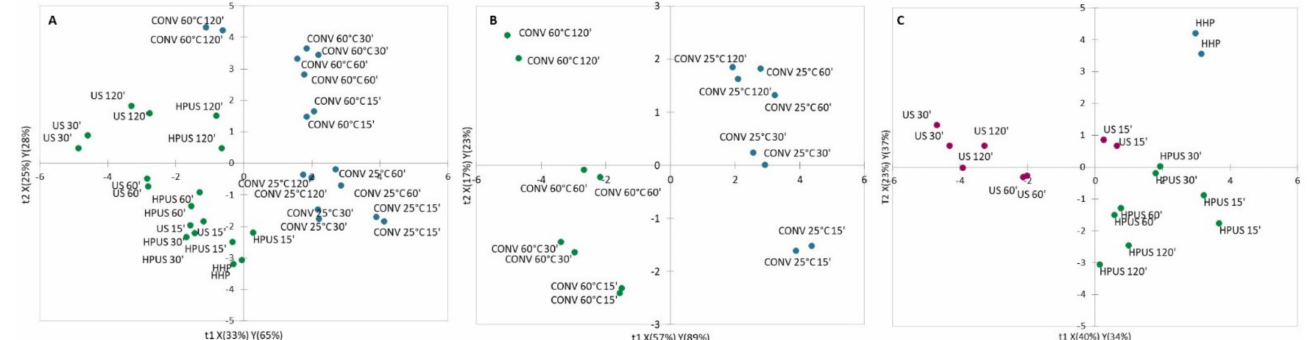
Figure 3. Score plots along the two of the PLS–DA model. Predictor variables were: ( A ) CONV (CONV 25 ◦ C and CONV 60 ◦ C) and INN (US, HPUS, HHP); ( B ) CONV 25 ◦ C and CONV 60 ◦ C; ( C ) US, HPUS, HHP extractions. CONV 25 ◦ C: conventional extraction at 25 ◦ C; CONV 60 ◦ C: conventional extraction at 60 ◦ C; HPUS: high power ultrasounds; US: low power ultrasounds;